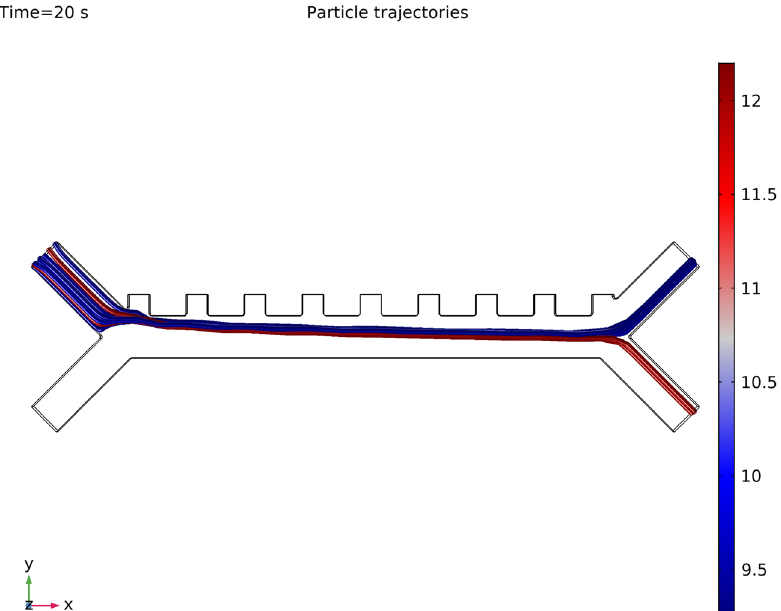
Figure 11. Particle Tracing result. Successful separation of CTC from leukocytes in the DEP stage. Cell suspension with random distribution of leukocytes and CTCs coming from the inertial stage enters into the inlet of the DEP stage. Color lines are cell trajectories, blue and its shades represent leukocytes while CTCs are represented by red